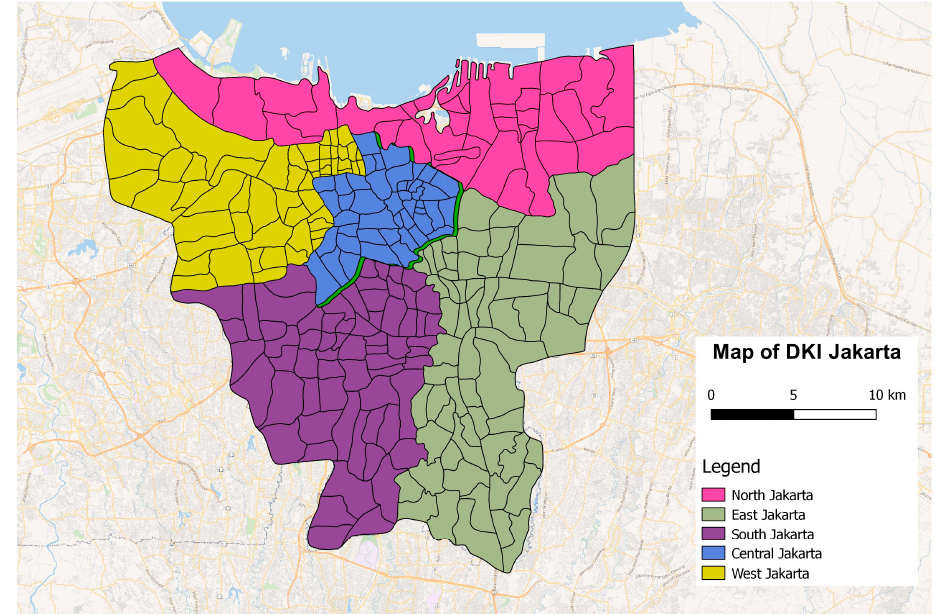
Figure 1. Map of Administration Division of the DKI Jakarta Province.